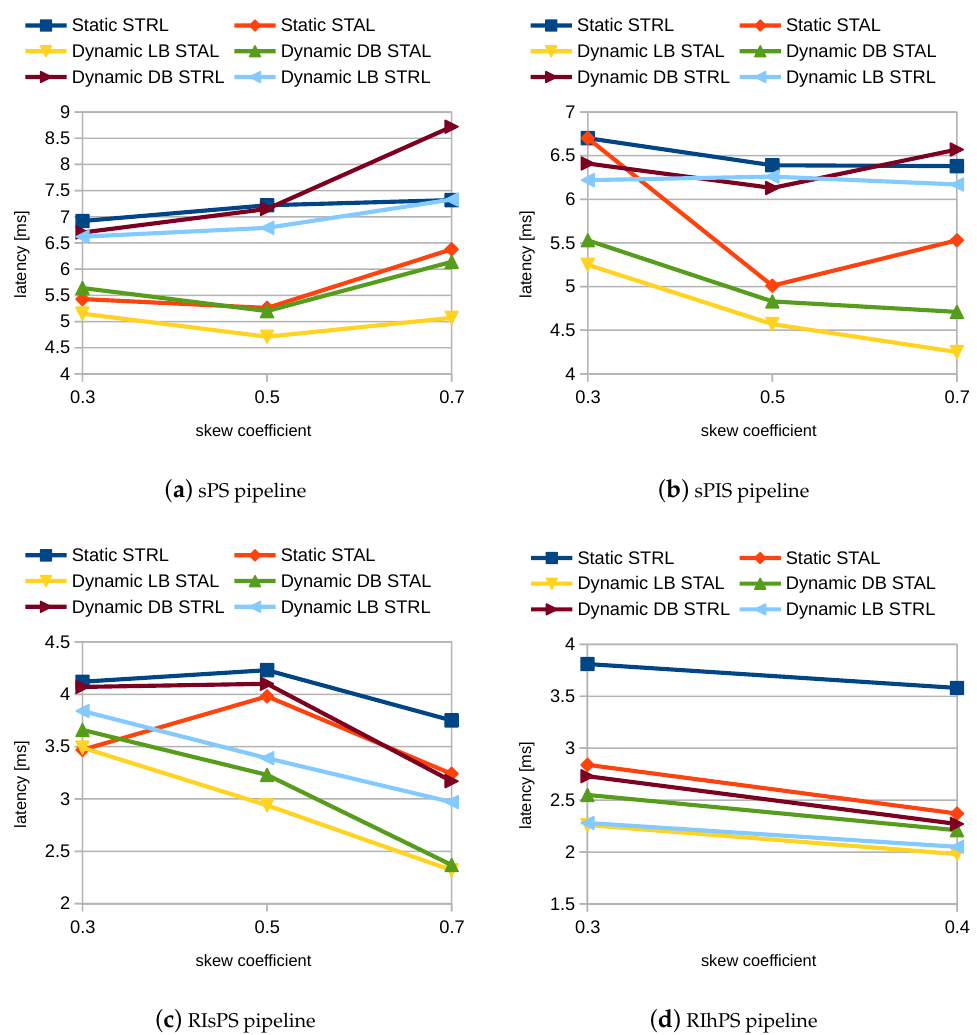
Figure 5. Average latency against skew coefficient for different modes and pipelines. While Figure 4 shows the average throughput as aggregated characteristics, Figure 6 shows how the throughput varied over time. The current throughput was shown by the solid line, while the average throughput was shown by the dashed line. We show the behavior of the sPS pipeline only because other pipelines and other modes followed a quite similar pattern. As expected, the throughput oscillated, during the experiment, around the average value. Again, we see that the difference in throughput increased with the increasing skew